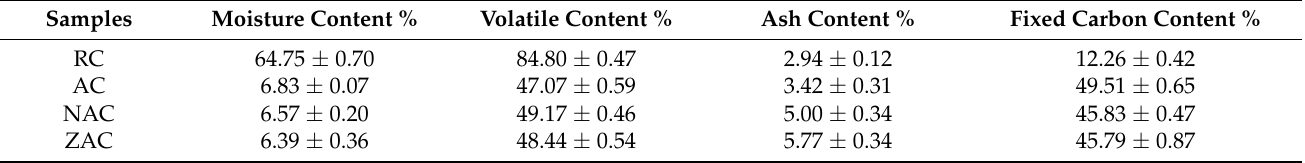
Table 3. Proximate analysis of surface-modified and nonsurface-modified activated-carbon-based cassava